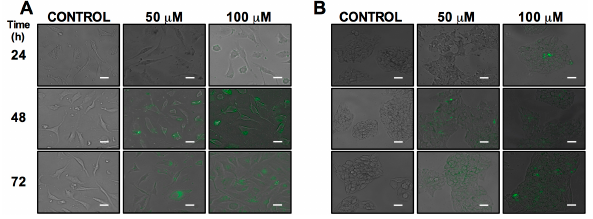
Figure 1. Cell uptake of the molybdenum cluster, and morphological changes in HepG2 and EA.hy926 cells. HepG2 ( A ) and EA.hy926 ( B ) cells were treated with the cluster for 24, 48 and 72 h. Pictures were taken under phase-contrast and epifluorescent microscope, showing that the cluster is incorporated